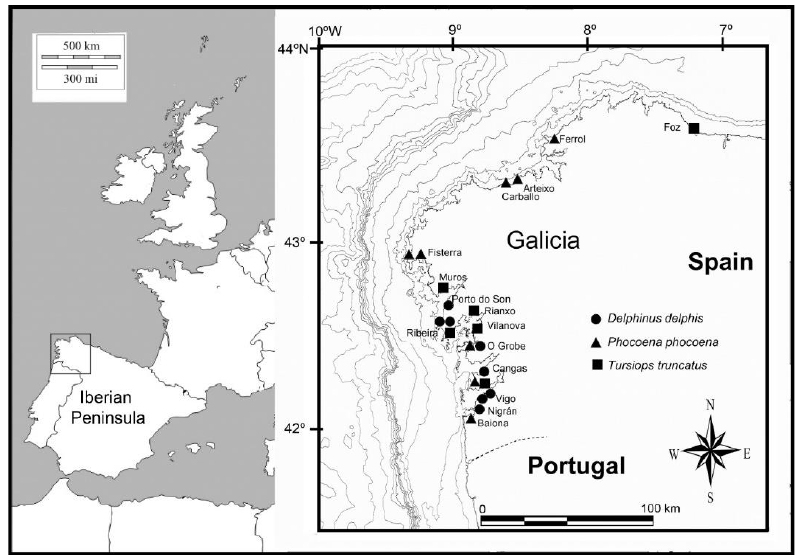
Figure 1. Location of stranded marine mammals collected along Galician coast that were used in the present study.